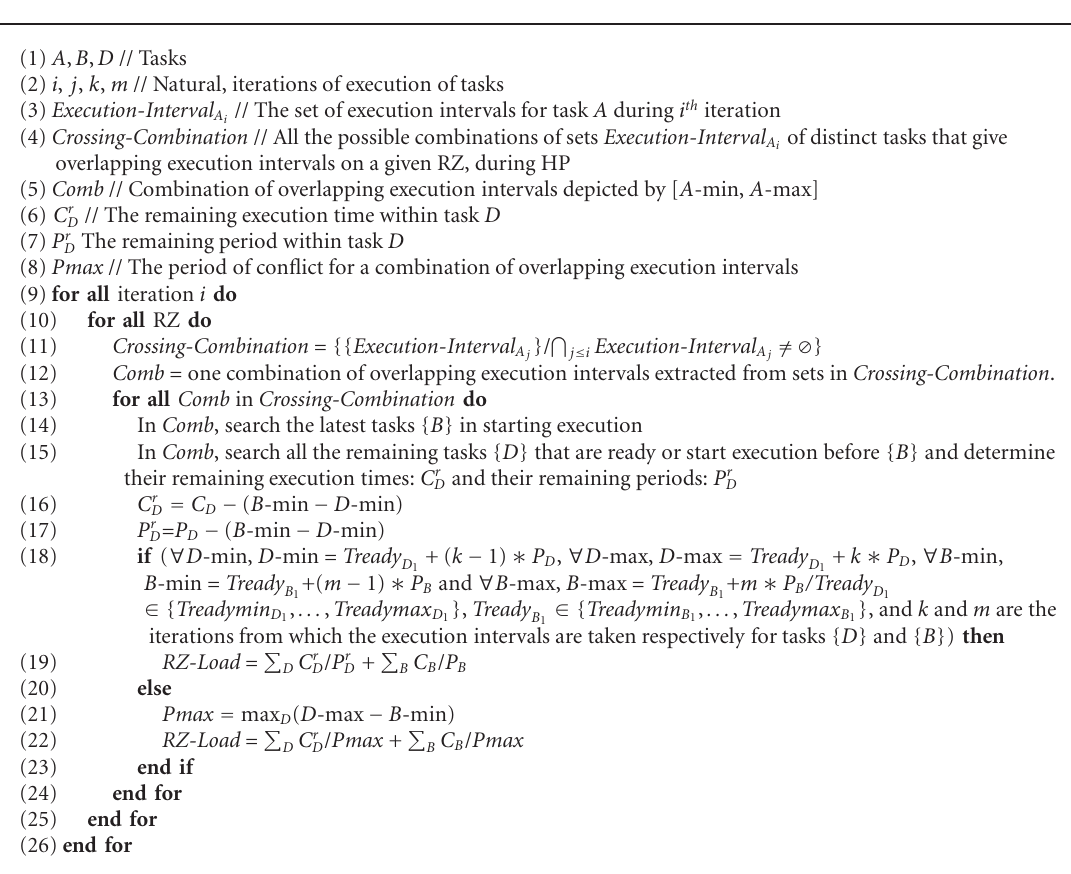
Algorithm 3: Search of overlapping execution intervals and RZ loads.